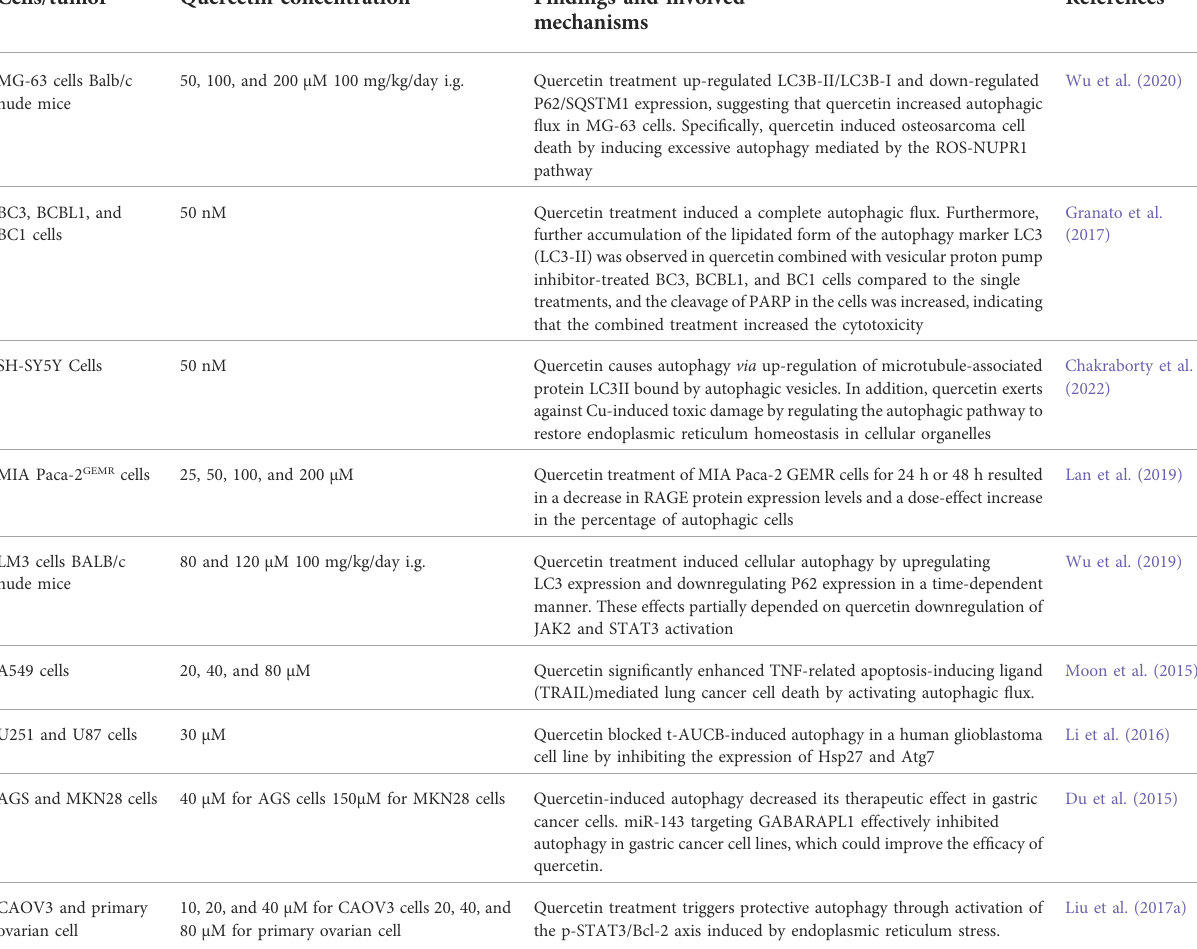
TABLE 1 Summarized mechanisms of autophagy following treatment with